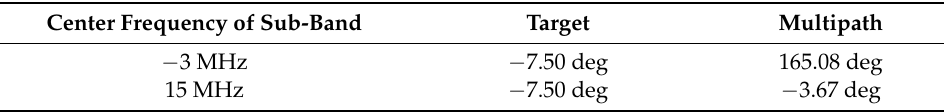
Figure 5. Simulation of the magnitude-phase superposed envelope in the MTC effect. ( a ) Out-phase superposed envelope with the center frequency of − 3 MHz. ( b ) In-phase superposed envelope with the center frequency of 15 MHz. Table 2. Phase Angle Analysis at Target Location.